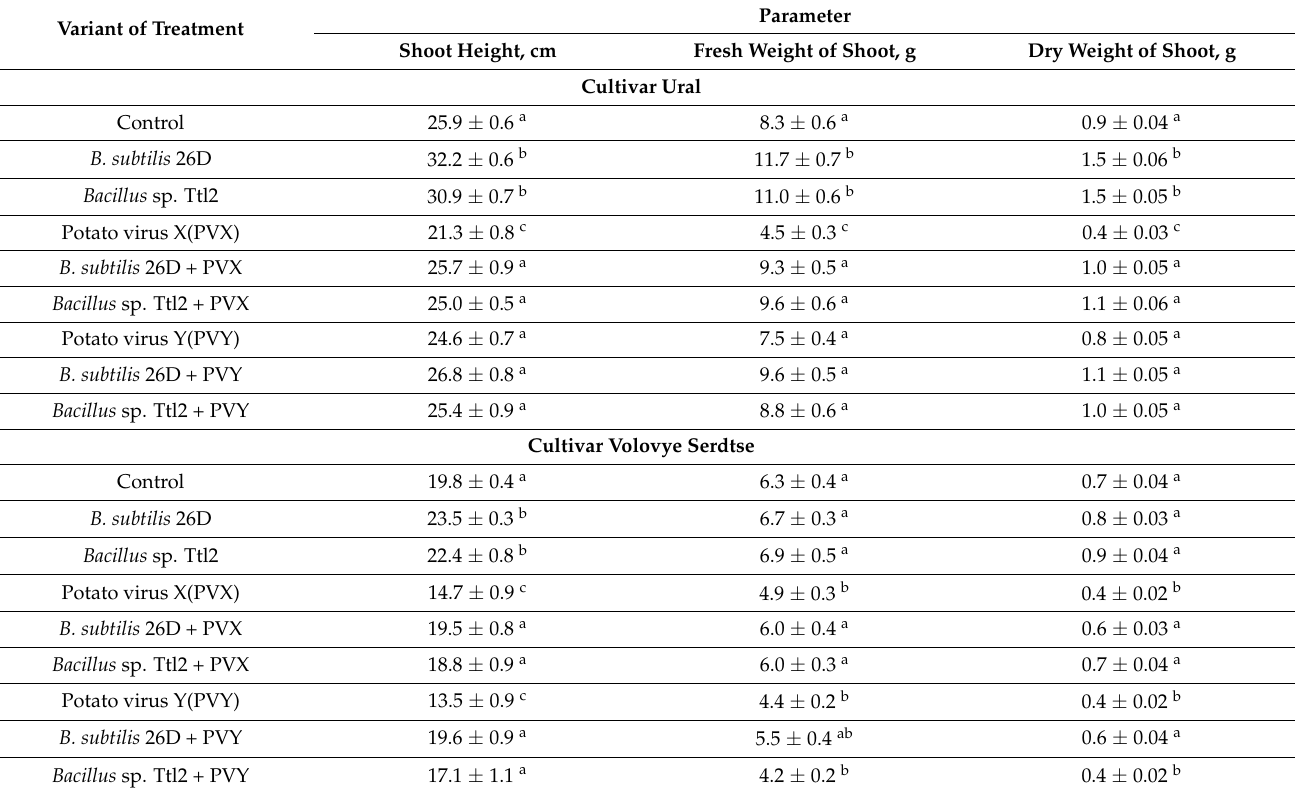
Table 2. Effect of the endophytic strains B. subtilis 26D and B. subtilis Ttl2 on the growth parameters of 2 varieties of tomato plants 2 weeks after infection with PVX and